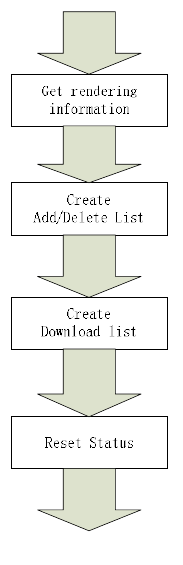
Figure 3. The Dispatch